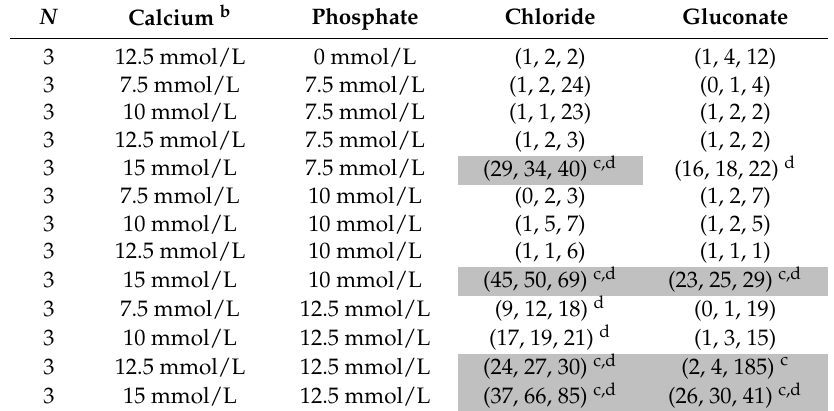
Table 5. Particle counts ≥ 10 microns per mL a for solutions compounded with Premasol ( N = number of bags). N Calcium